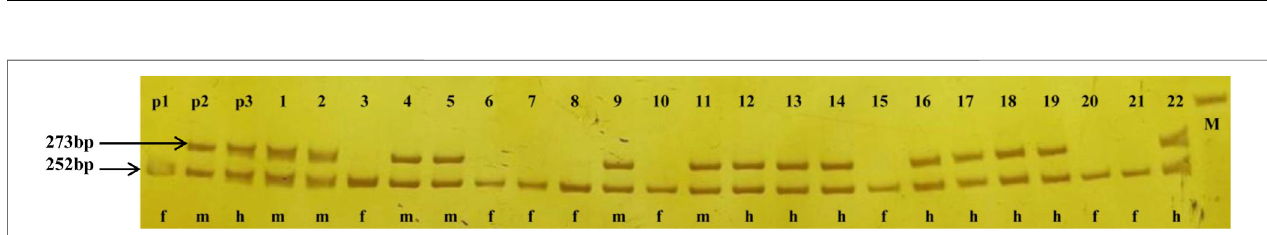
Frontiers in Genetics |